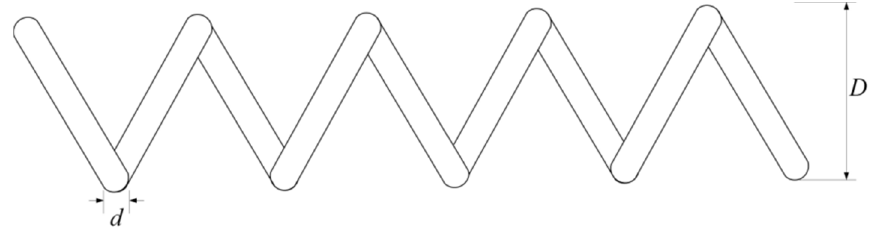
Figure 14. Schematic view of the Tension/Compression Spring design.